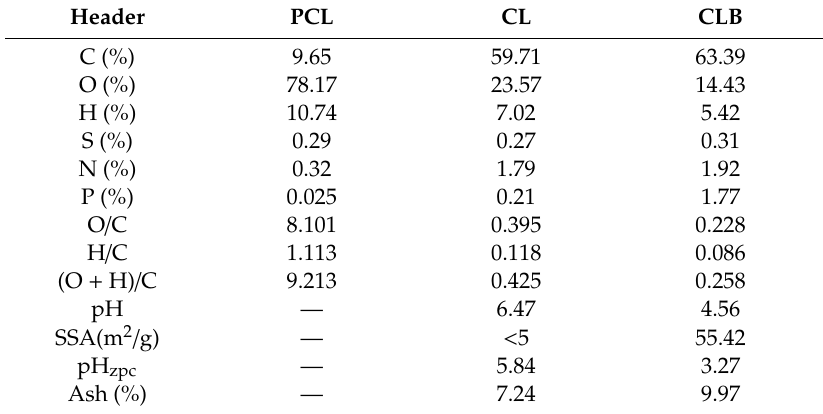
Table 1. Elemental composition, pH, SSA, and pH zpc values of pristine cauliflower leaves(PCL), cauliflower leaves(CL), and cauliflower leaves biochar (CLB). Header PCL CL